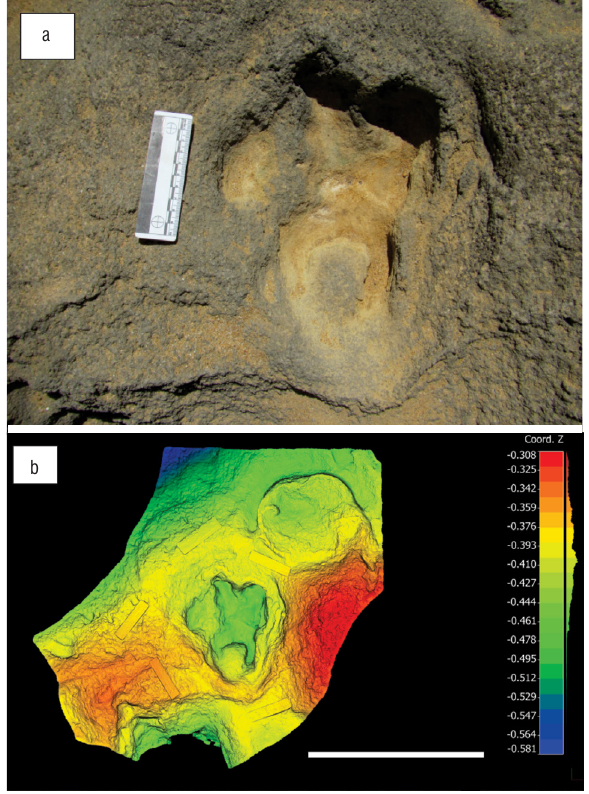
Figure 9: (a) Large, three-toed, probable rhinoceros track on Megafauna Rock. (b) Photogrammetry colour mesh: probable rhinoceros track (centre) and at least one elephant track (upper right). 3D model was generated with Agisoft Photoscan Professional (v. 1.0.4) using 33 images from a Canon PowerShot ELFPH 340 HS (focal length 4.5 mm; resolution 4608 x 3456; pixel size of 1.33853 x 1.33853 um). Photos were taken an average of 0.42 m from the surface. The surface model error is 0.144403 pix. The final images presented here were rendered using CloudCompare (v.2.6.3.beta). Vertical scale bar is in